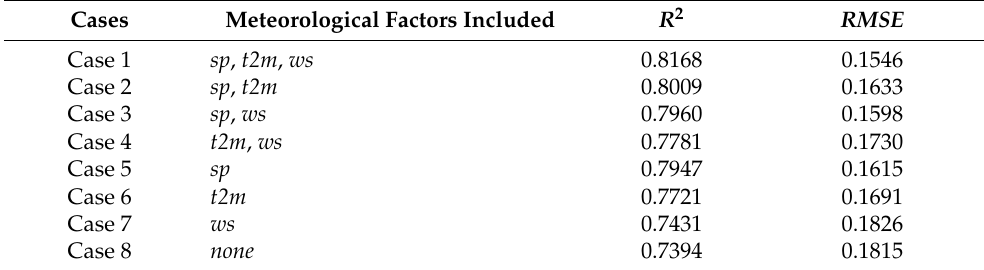
Figure 11. Comparisons between DNN-estimated AHI AOD and AERONET AOD for Cases 1~8 with different input meteorological features. Table 4. R 2 and RMSE of 8 cases with different input meteorological